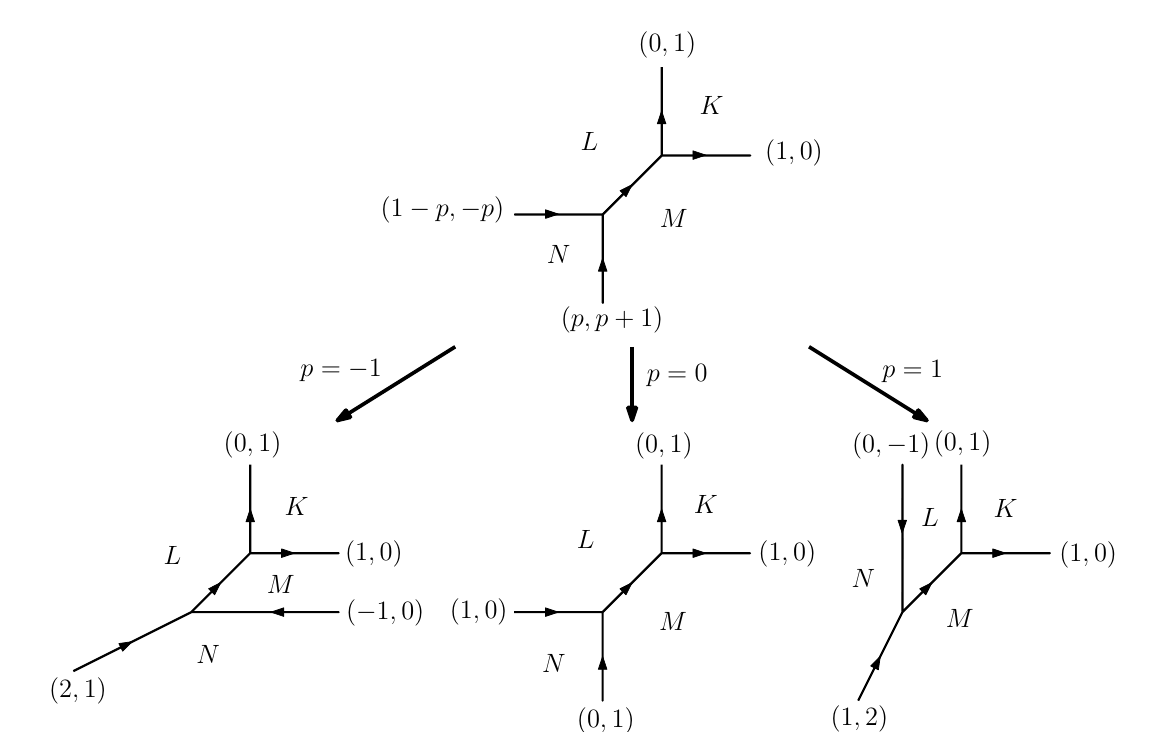
Figure 8. Con(cid:12)gurations containing a simple (cid:12)nite leg segment. The p = (cid:6) 1 cases are related by S-duality and it acts within the family of p = 0